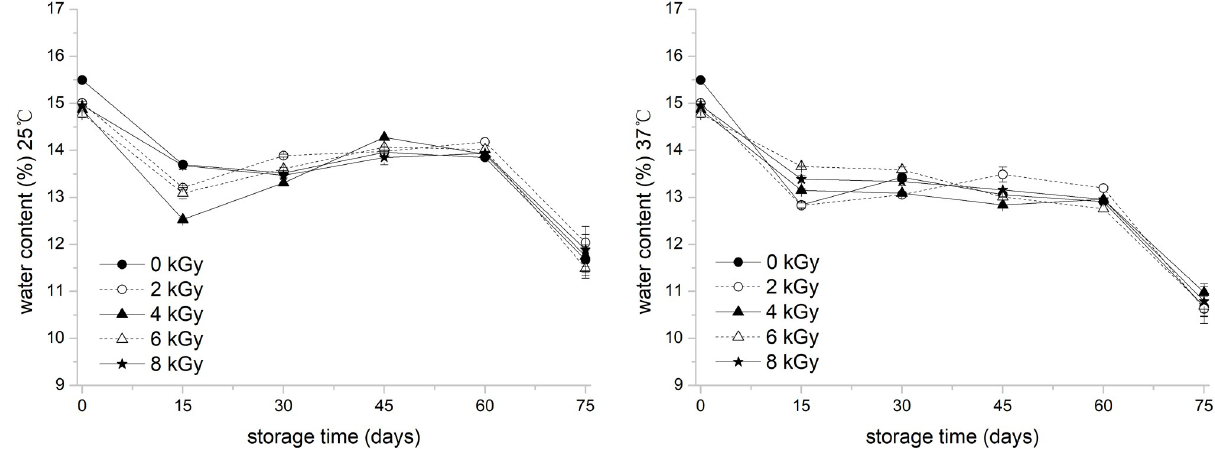
Fig 1. Water content variance of electronic -beam -irradiated white rice at 25 ˚C and 37 ˚C with 75 days of storage. Error bar represents standard deviation ( n = 3).